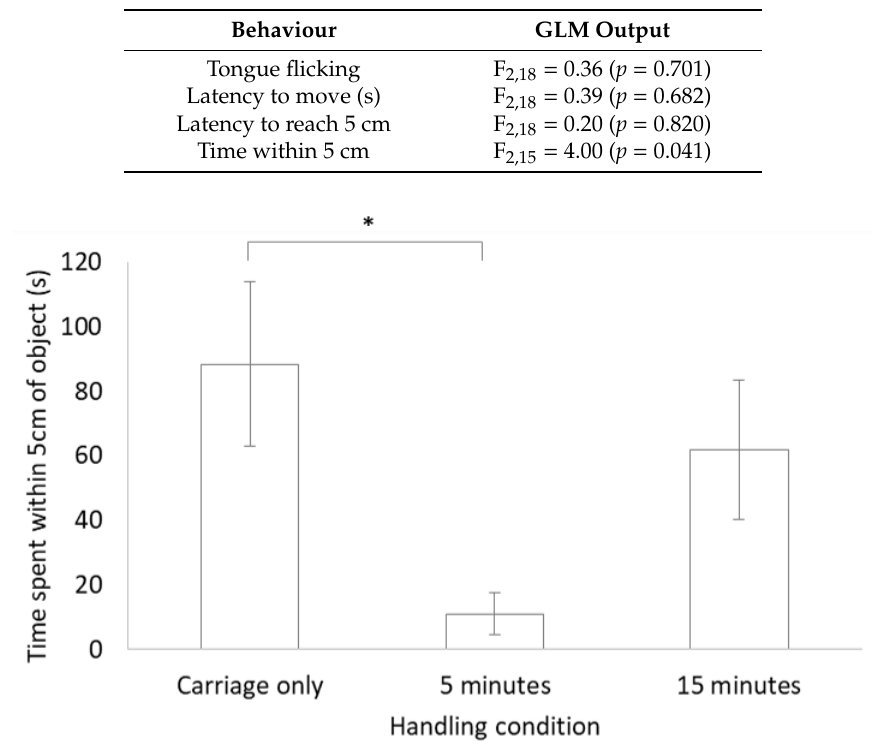
Figure 2. Bar chart of mean ± standard error for the time spent within 5 cm of the object during the novel object test for lizards in the three different handling conditions. * indicates a significant difference ( p < 0.05).